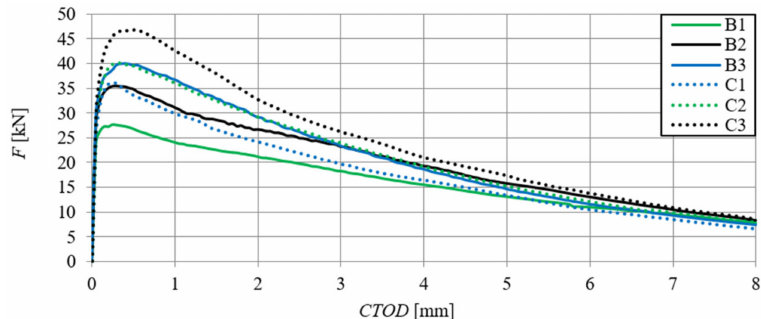
Figure 8. Force–deflection relationships obtained on the basis of the arithmetic mean of the results for beams from series A, B, and C.